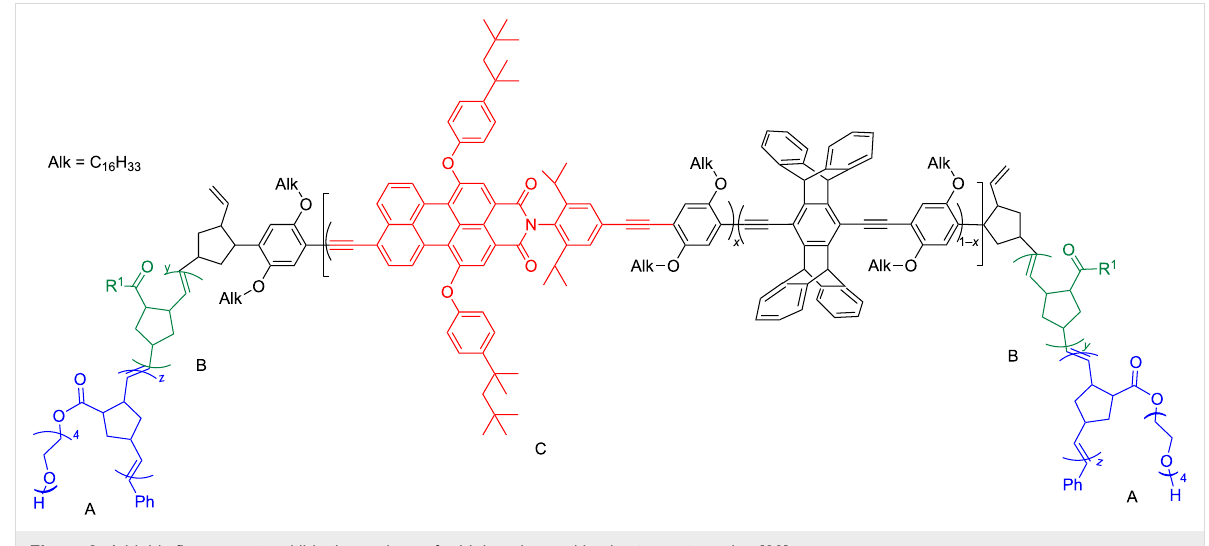
Figure 2: A highly fluorescent multiblock copolymer for bioimaging and in vivo tumor targeting [60].